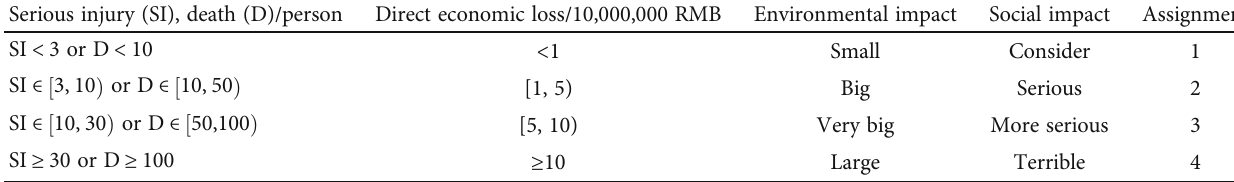
Table 1: Degree of consequence grade index.